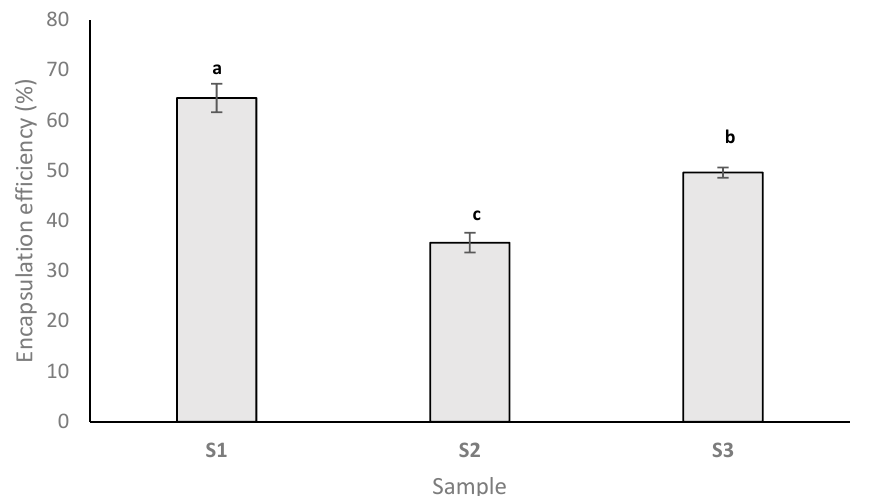
Figure 1. The encapsulation efficiency (EE) of the resulting powders. Columns not sharing the same letter (a, b, c) are significant at p < 0.001, based on the post-hoc Tukey test.